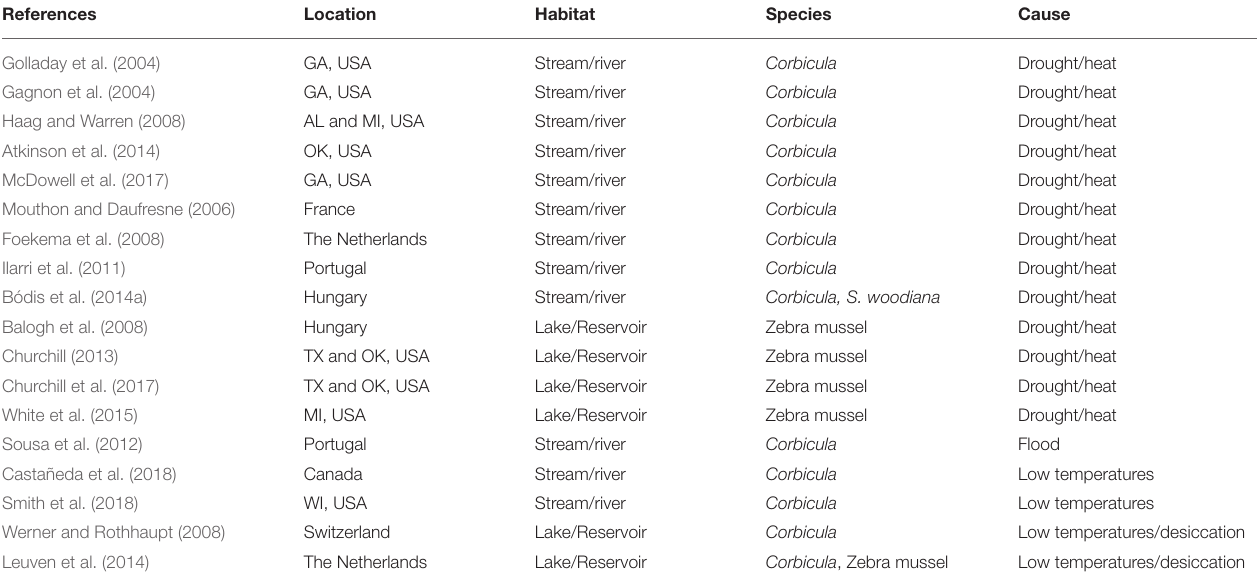
TABLE 1 | Summary of documented mass mortality events of invasive bivalves. Studies are sorted by cause, then